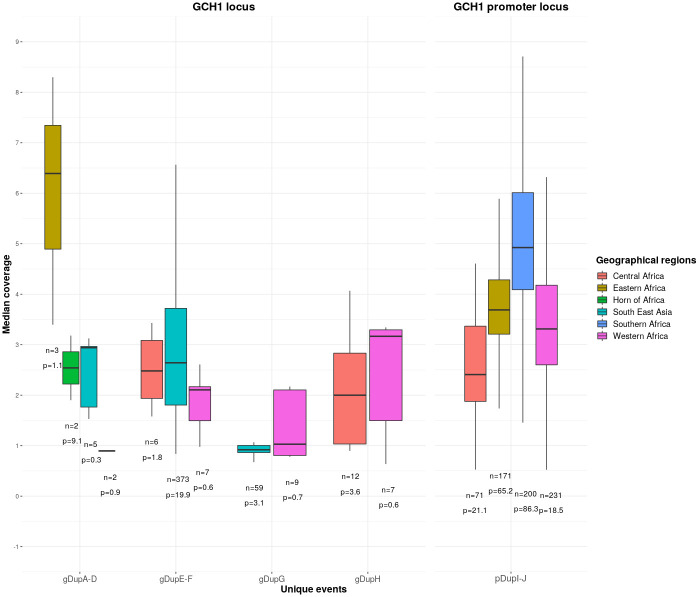
Copy numbers of the pfgch1 amplifications.n—number of samples with amplification; p—percentage of samples with amplification.